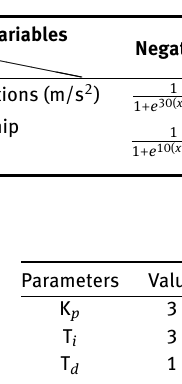
Table 4. Linguistic variable functions for each input channel